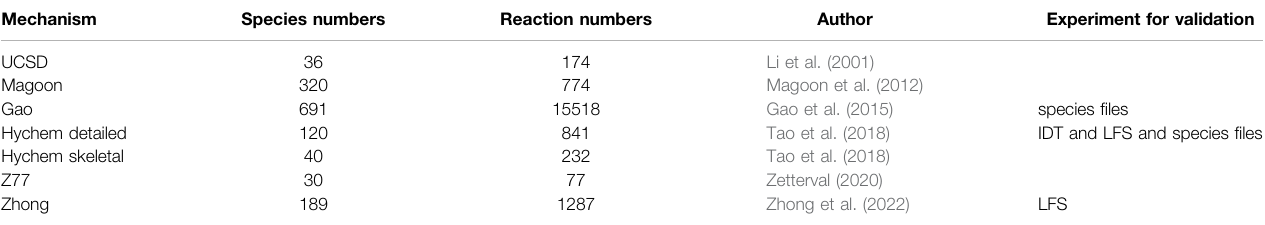
TABLE 3 | Combustion mechanism studies of JP-10 in